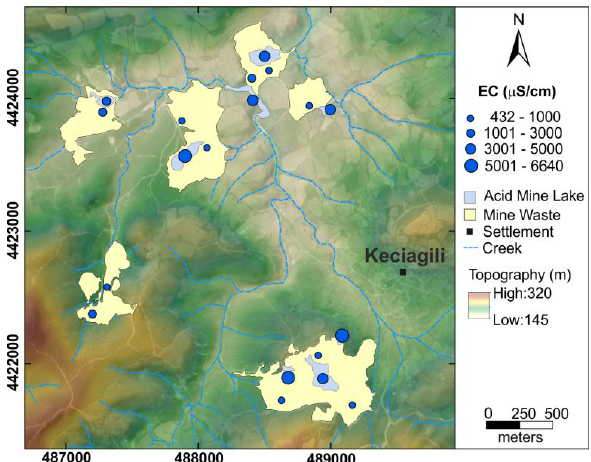
Figure 4. EC distribution of mine wastes and acid mine